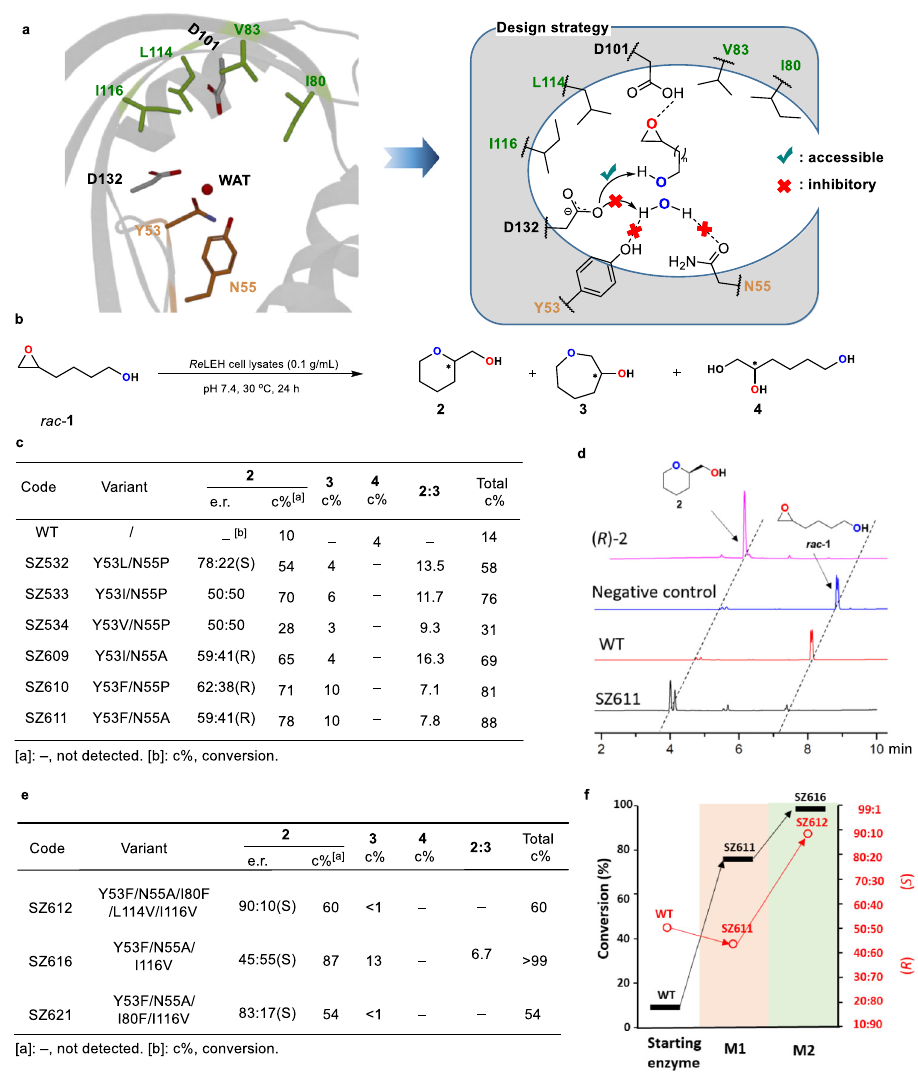
Fig.2|Reprogrammingthecatalyticrepertoireof Re LEHtowardstheBaldwin- typereactions.a Design strategyof breaking the water binding networkin Re LEH. b Re LEH-catalyzed model reaction leading to three distinct products. c Screening results of the fi rst round of mutagenesis performed on residues 53 and 55. d GC pro fi les of the mutant SZ611. e Screening results of the second round of